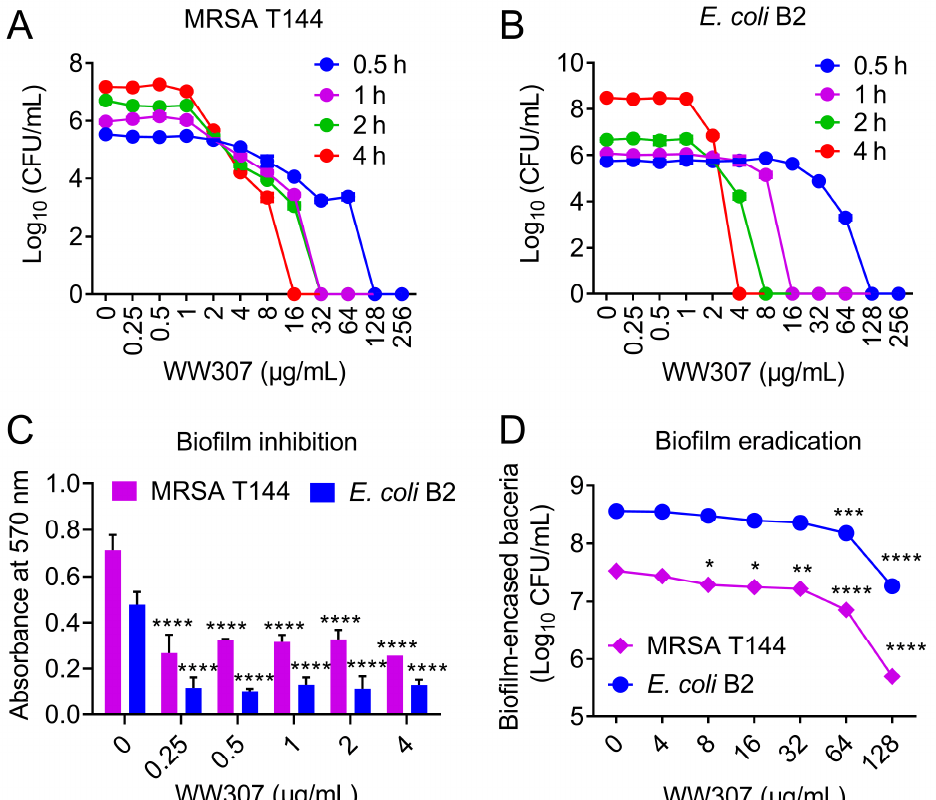
Figure 5. Bactericidal ability and anti ‐ biofilm activity of WW307. ( A , B ) The time ‐ and concentration ‐ killing curves of WW307 against MRSA T144 and E. coli B2. The mixture of varying concentrations of WW307 (0–256 μ g/mL) and bacterial solution was incubated at 37 °C for 0.5, 1, 2, and 4 h, respectively. Afterwards, ten ‐ fold serially suspensions were plated on MHA plates and incubated overnight, and the corresponding CFUs were counted and calculated. ( C ) Inhibitory effects of WW307 on MRSA T144 and E. coli B2 biofilm formation. Bacterial cells were cultured in 96 ‐ well plates at 37 °C with or without WW307 (0–4 μ g/mL). After 48 h incubation, the biofilm mass was determined using crystal violet method. ( D ) Eradication abilities of WW307 against mature biofilm by MRSA T144 and E. coli B2. Bacterial suspensions were cultured at 37 °C for 48 h. Then, WW307 from 0 to 128 μ g/mL was added and incubated at 37 °C for 2 h. Eradication effect of WW307 on biofilm was evaluated by determining the remaining CFUs. All data from at least three biological replicates were pre ‐ sented as mean ± SD, and the statistical significance was determined by unpaired t test ( C ) or non ‐ parametric one ‐ way ANOVA (D) (* p < 0.05, ** p < 0.01. *** p < 0.001, **** p < 0.0001).